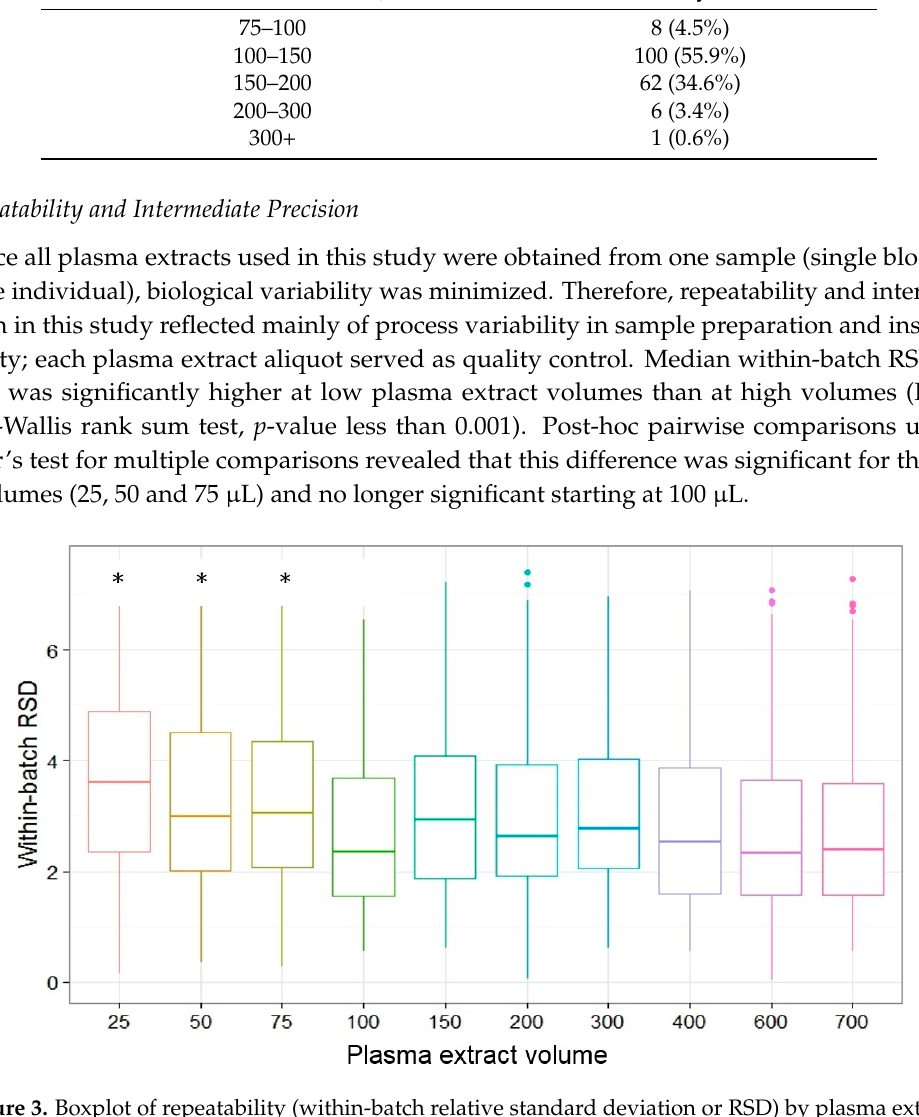
Figure 3. Boxplot of repeatability (within-batch relative standard deviation or RSD) by plasma extract volume. The horizontal lines represent the median and the lower and upper hinges correspond to the 25th and 75th percentiles. The asterisks * denote RSD that was significantly different in post-hoc pairwise comparisons using the Conover’s test for multiple comparisons.